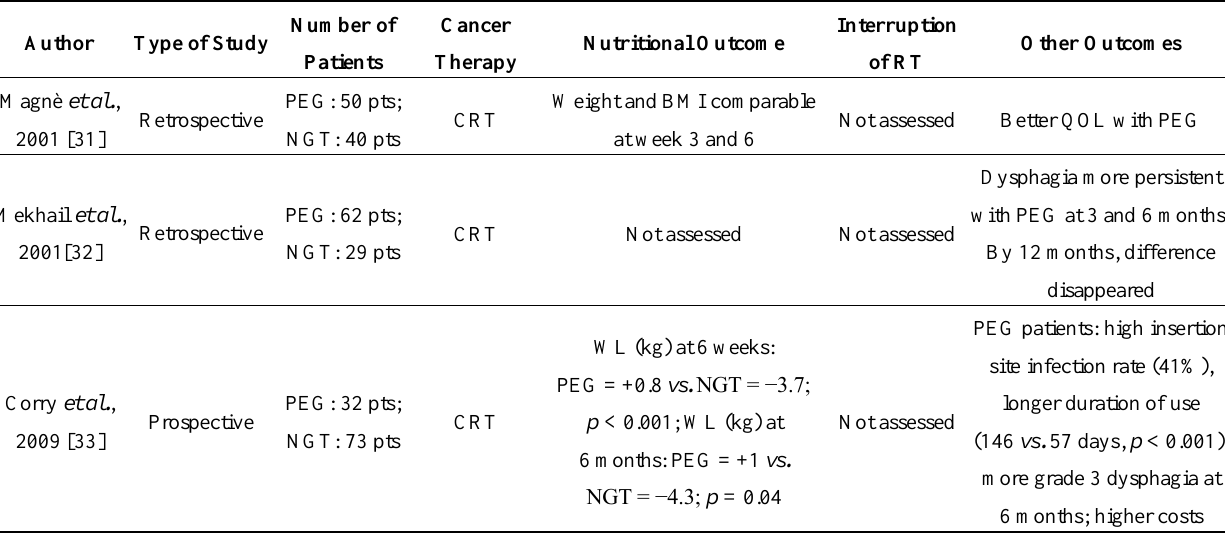
Table 2. Enteral feeding in head and neck cancer patients receiving chemoradiotherapy (CRT): comparison of nasogastric tube (NGT) and percutaneous gastrostomy (PEG). WL, weight loss; QOL, quality of